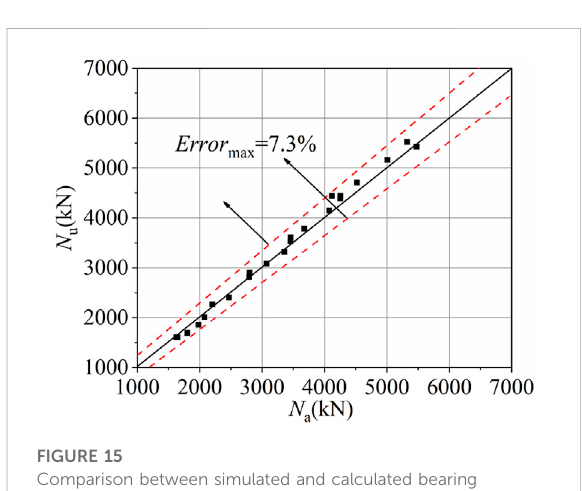
FIGURE 15 Comparison between simulated and calculated bearing capacity of 22 HCHST composite